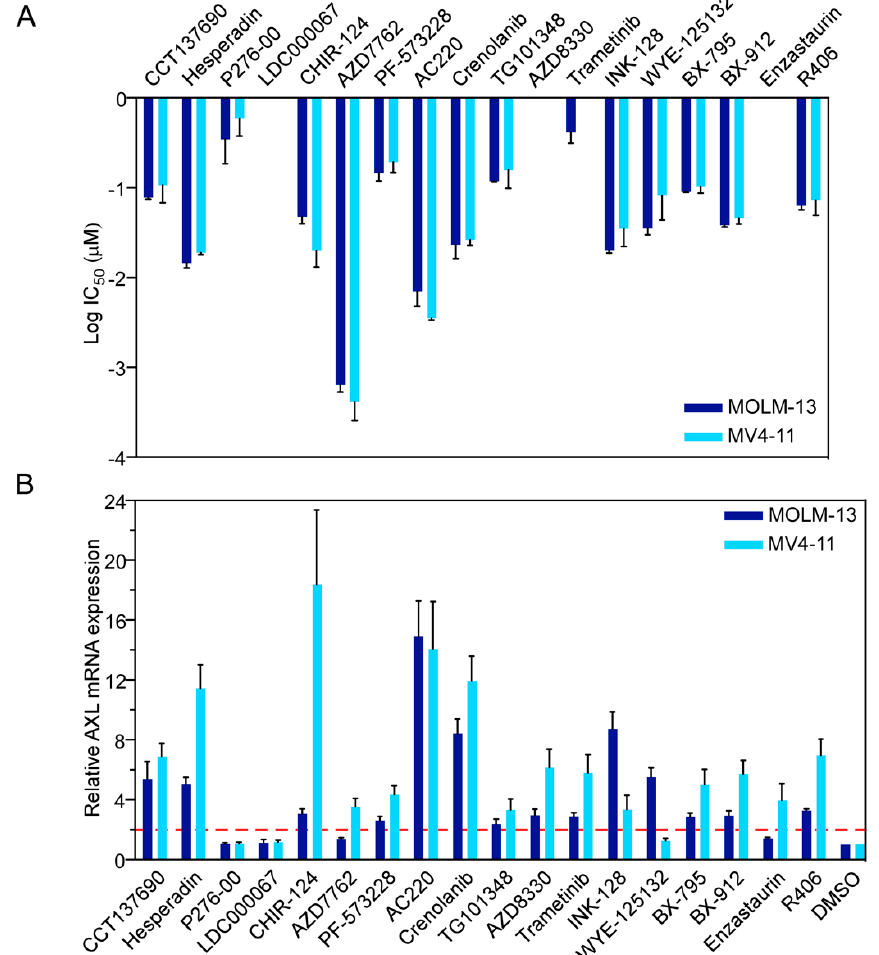
Figure 4. Drug − induced AXL expression in AML cell lines. ( A ) MV4 − 11 and MOLM − 13 cells were treated with different concentrations of kinase inhibitors for 48 h. Cell viability was measured using PrestoBlue. ( B ) MV4 − 11 and MOLM − 13 cells were treated with different kinase inhibitors for 24 h with respective EC 50 values and AXL expression was measured using RT − qPCR.